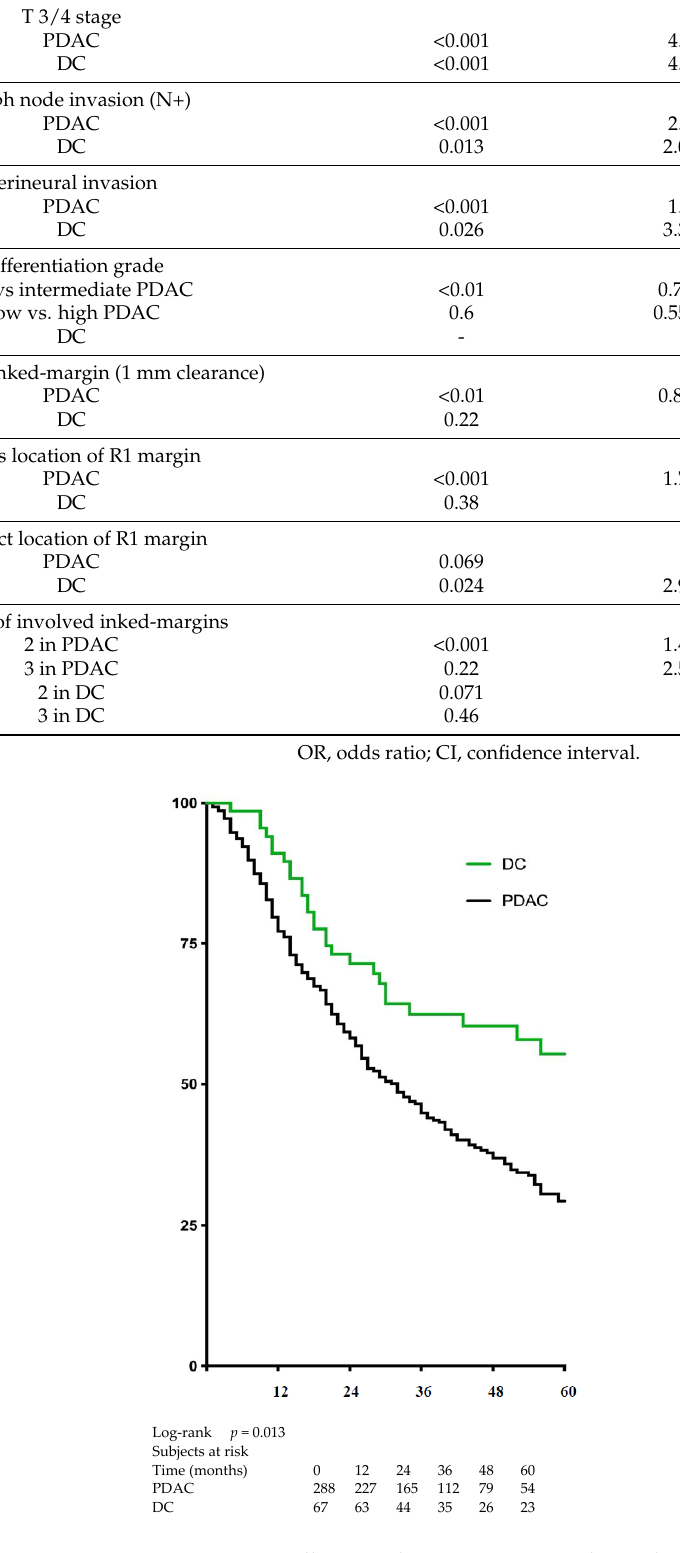
Figure 3. Overall survival among patients who underwent resection for distal cholangiocarcinoma (DC) or pancreatic ductal adenocarcinoma